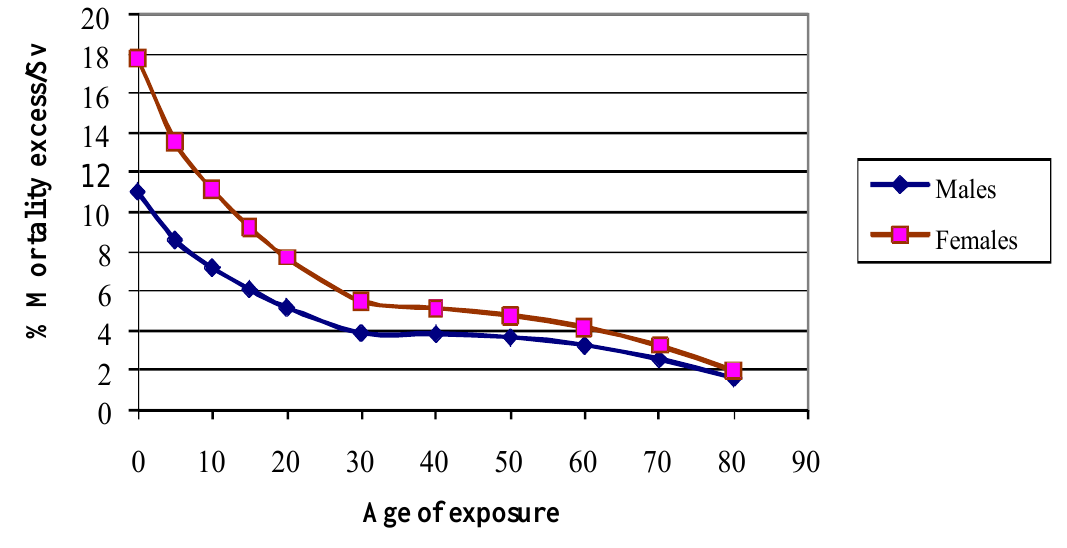
Figure 3. Radiation- Induced Risk of Cancer on Age and Gender by using the BEIR VII